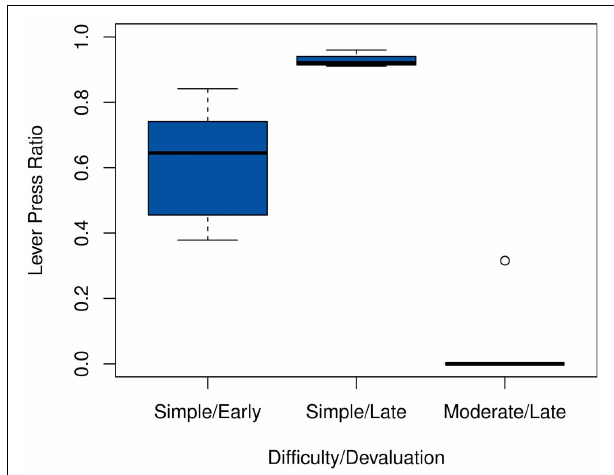
FIGURE 3 | Post-devaluation frequency of choosing the lever press action in the starting state. Values are relative to their respective pre-devaluation rates. Comparisons are between the 100 cycles before and after the devaluation for the late settings, and 20 cycles for the early one. Note that action choices are determined before exploration, hence the sharp drop in the moderate task.